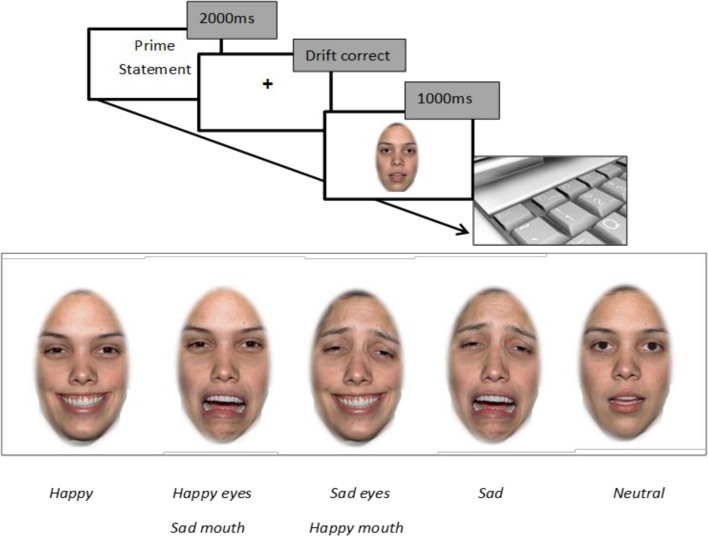
Schematic of experiment.